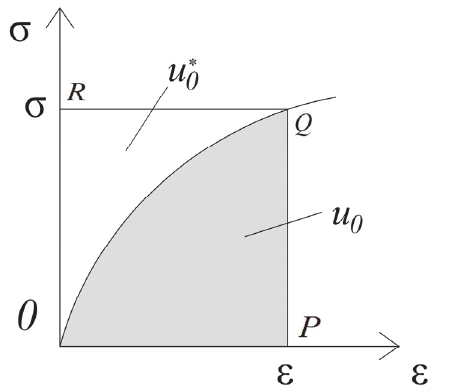
Figure 4: Schematic of a non-linear stress-strain curve ( 0 u and * 0 u are the strain energy density and the complementary strain energy density,